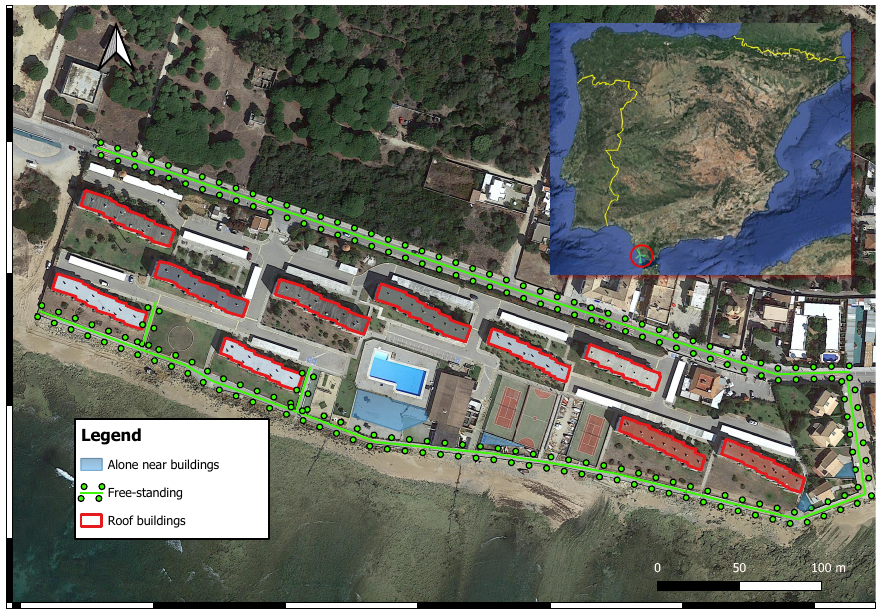
Figure 6. Overview of the study site. Authors’ own